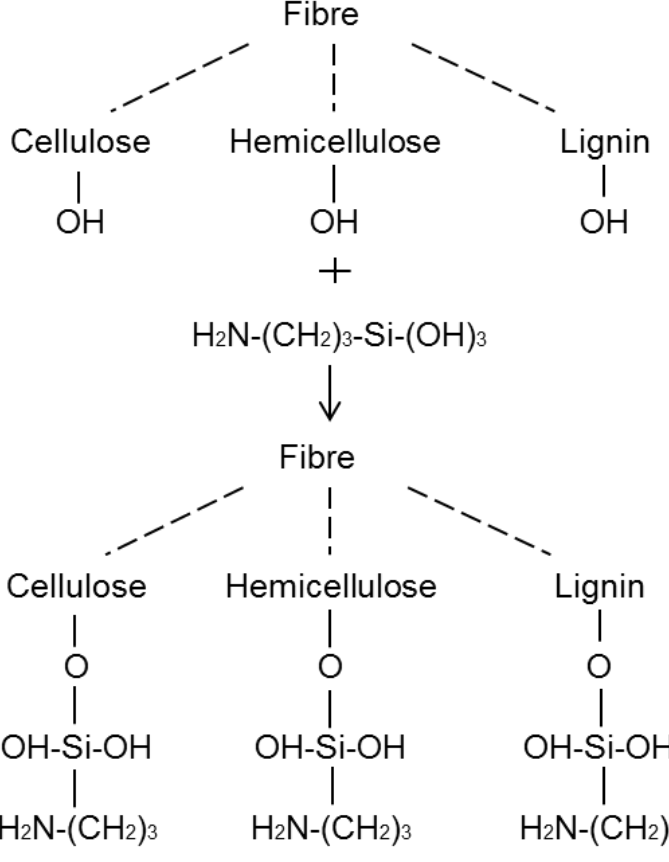
Figure 5. Grafting of silanols on flax fibre surface (redrawn from Singha et al .